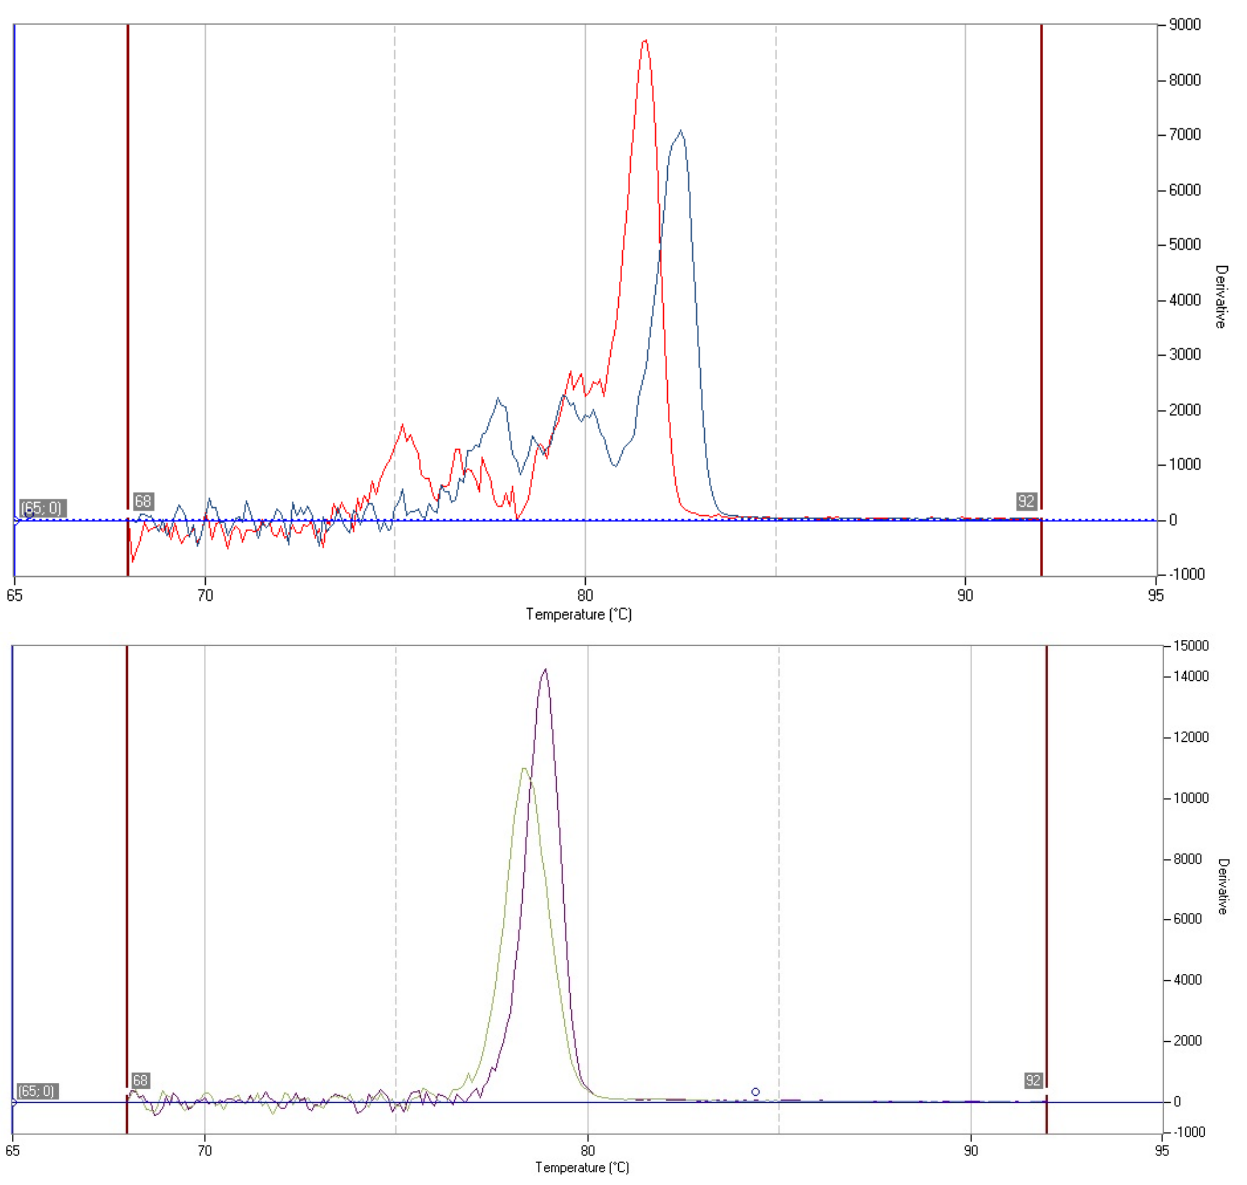
Figure 5. Allele-specific melting curve analysis. The different allele sizes at marker (GAAA) 34 ( upper panel ) in isolates from Germany (325 bp) and Australia (491 bp) resulted in different melting temperatures of the fragments (differences 0.88 °C and 166 bp). Similarly, this was also observed at the (CTT) 56 locus, where the melting temperature difference was 0.45 °C and the fragment size difference was only 12 base pairs (( lower panel ) Australia 301 bp and Germany 289